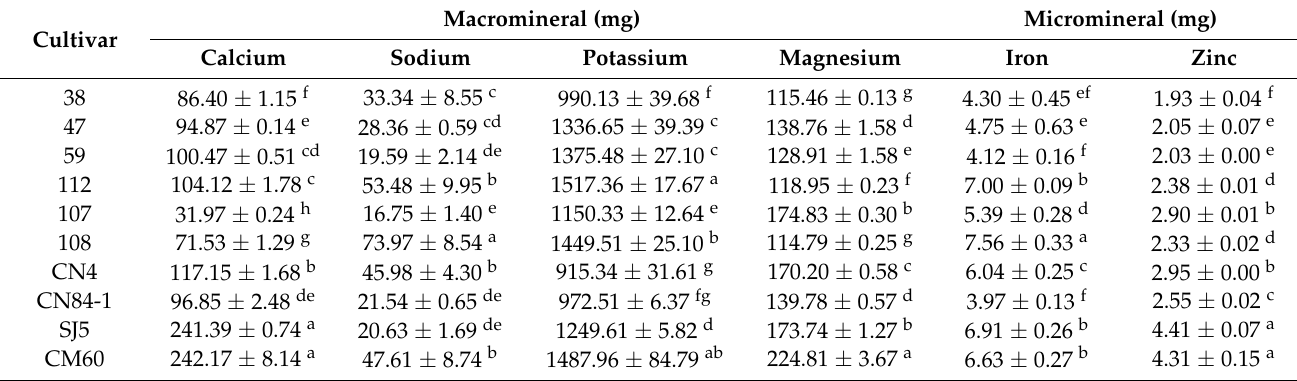
Table 4. Mineral contents of ten bean cultivars (per 100 g dry